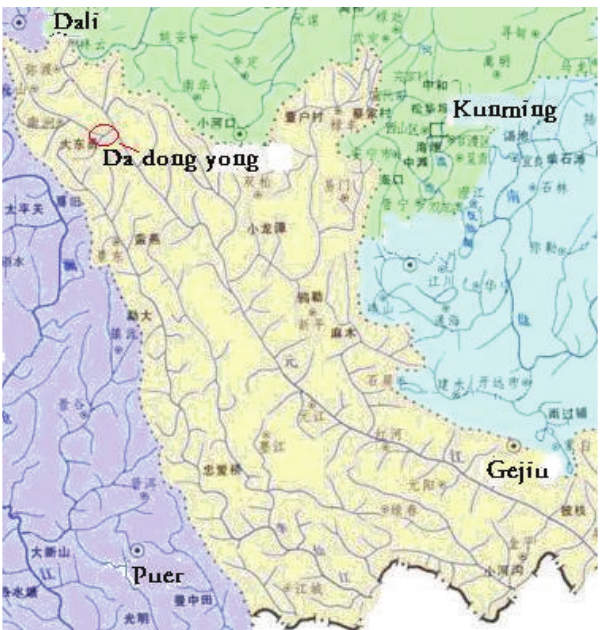
Figure 1: Water system diagram of Red River Basin of China.